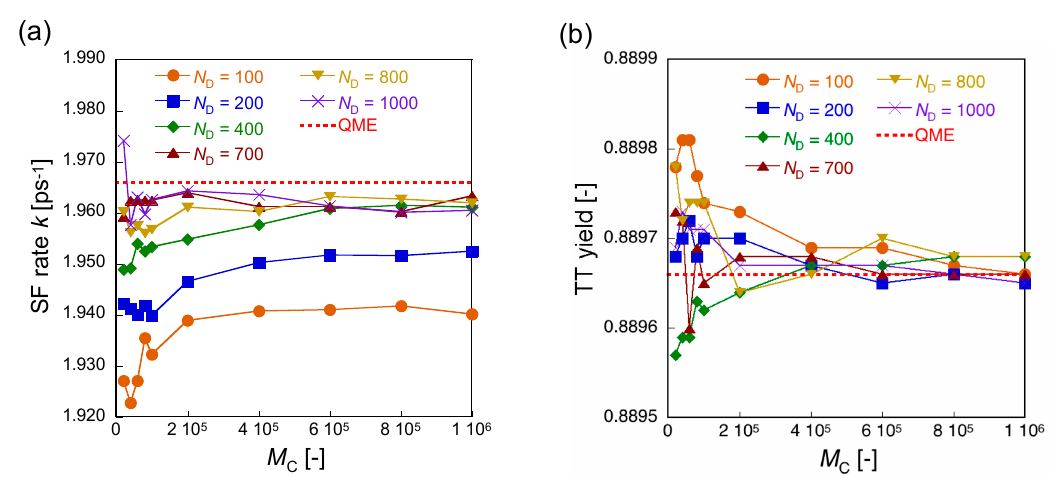
Figure 4. Variations of SF rate k [ps − 1 ] ( a ) and TT yield a [ − ] ( b ) for the pentacene dimer model (Figure 1b) as a function of the number of Monte Carlo trajectories ( M C ) for different division number N D . For ( a ) and ( b ), the horizontal dotted lines show k = 1.966 ps − 1 and a = 0.88966, respectively, obtained by the QME approach.